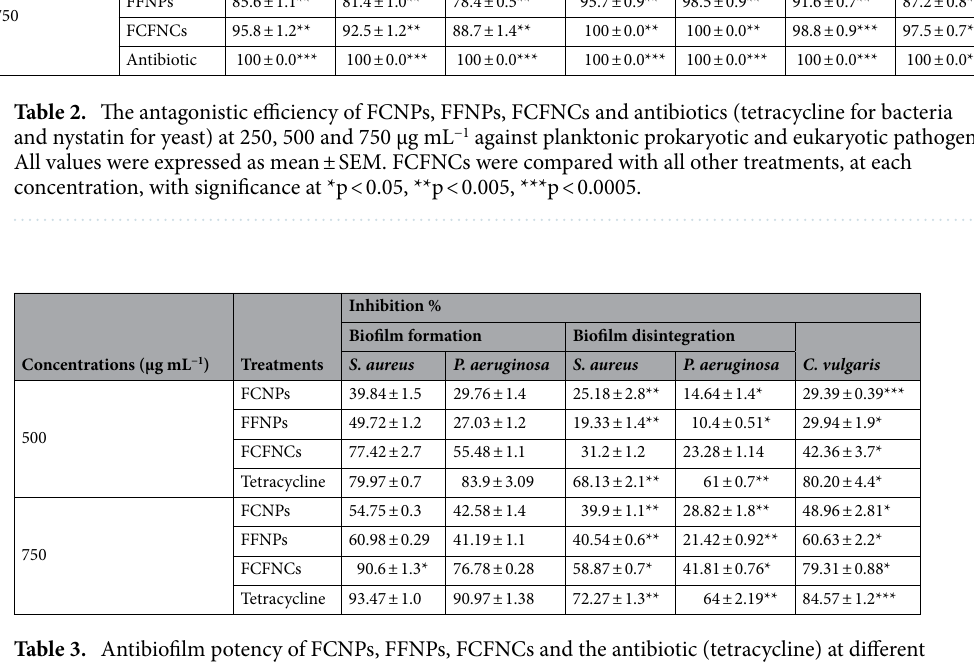
Table 3. Antibiofilm potency of FCNPs, FFNPs, FCFNCs and the antibiotic (tetracycline) at different concentrations in response to biofilm evolution and degradation. All values were expressed as mean ± SEM. FCFNCs were compared with all other treatments, at each concentration, with significance at *p < 0.05, **p < 0.005, ***p <